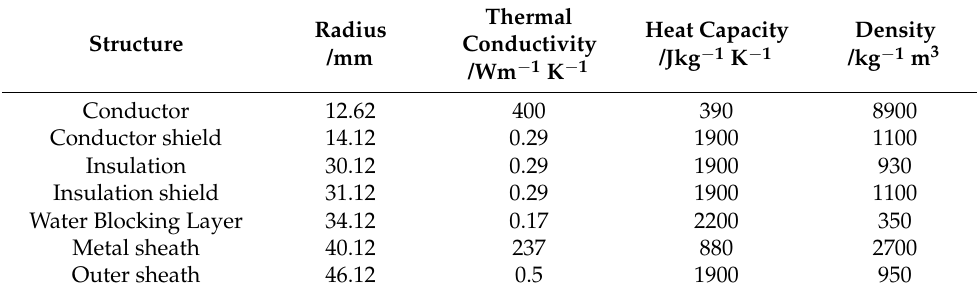
Table 2. Structural dimensions and material properties in the geometric model.